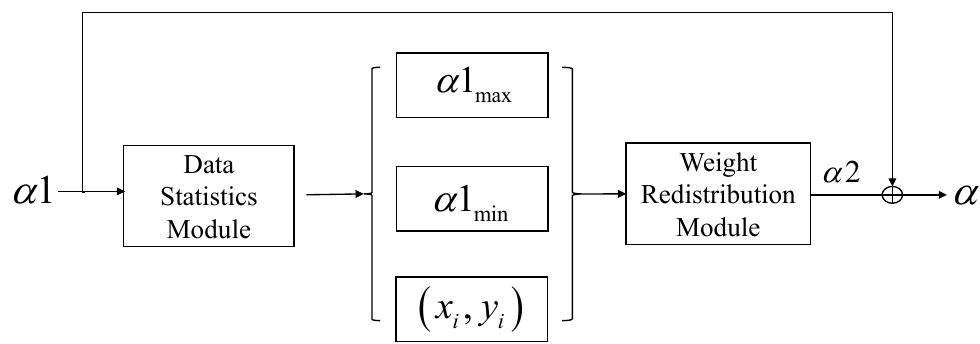
Figure 2. The structure of MSISAM, which consists of two modules: A data statistics module and a weight redistribution module. The symbol (cid:76) is the plus